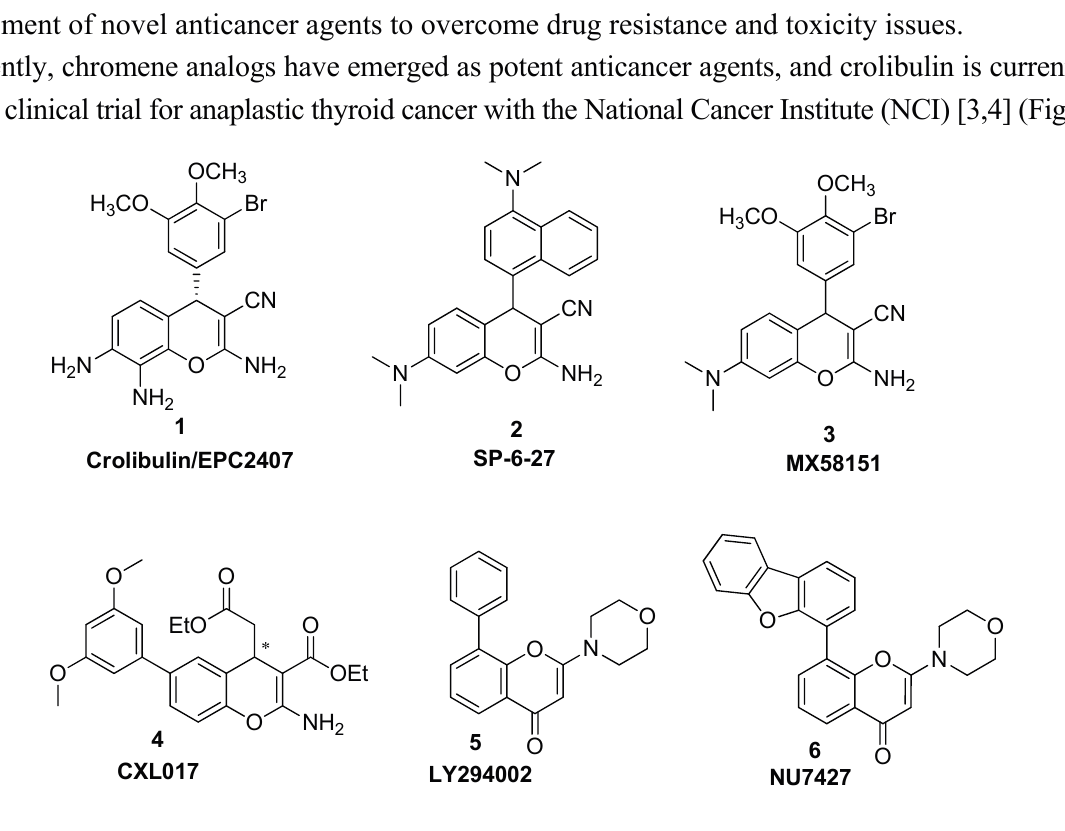
Figure 1. Chromene-based anti-cancer